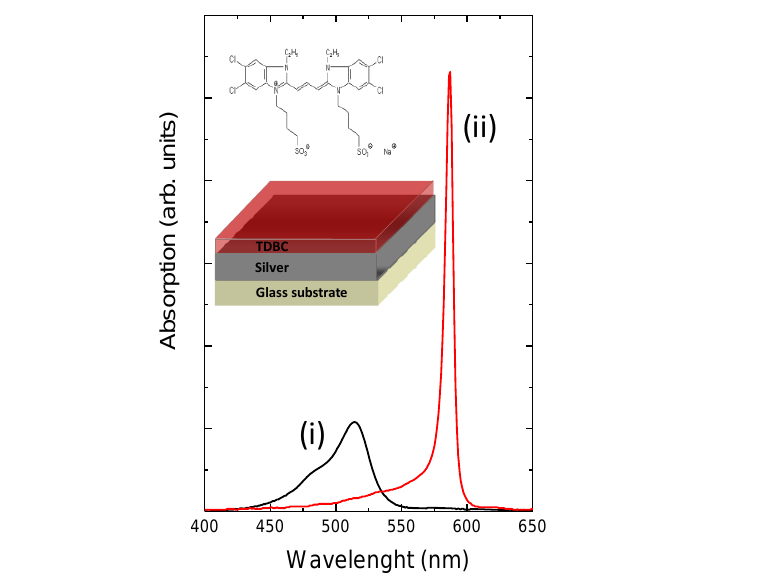
Figure 1. Absorption spectra of a solution of (i) TDBC monomer (black line) and (ii) TDBC J-aggregates in water (red line). The inset presents the chemical formula of TDBC and a sketch of a typical